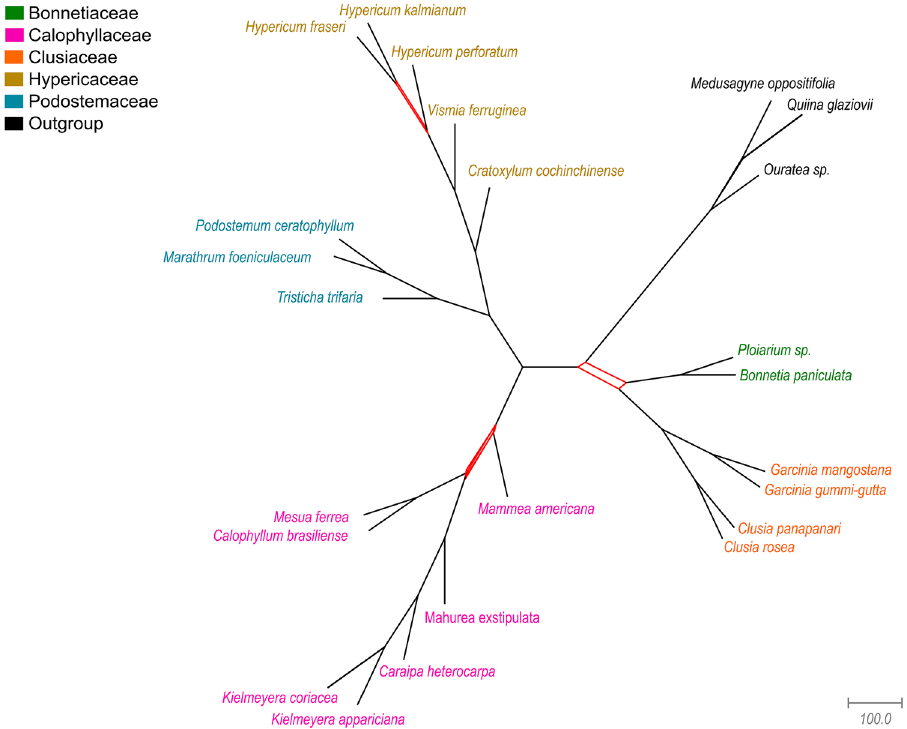
Figure 4. Network representation of the relationships within the clusioid families. Compatible sets of splits are represented by a single branch, and splits where there is incompatibility are represented by a band of parallel branches, colored in red. Families are colored following the legend; names in black denote the